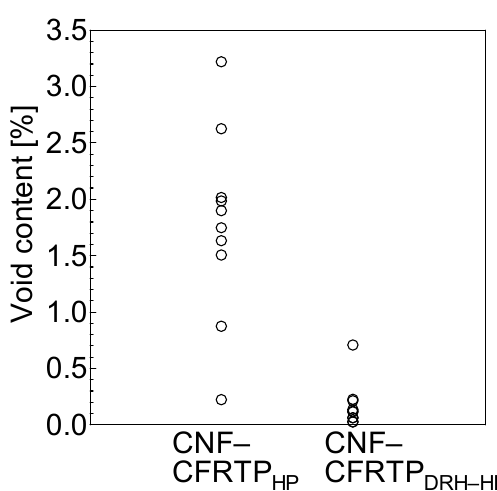
Figure 17. Void content of CF-CFRTP and CNF-CFRTP calculated by using SEM images.